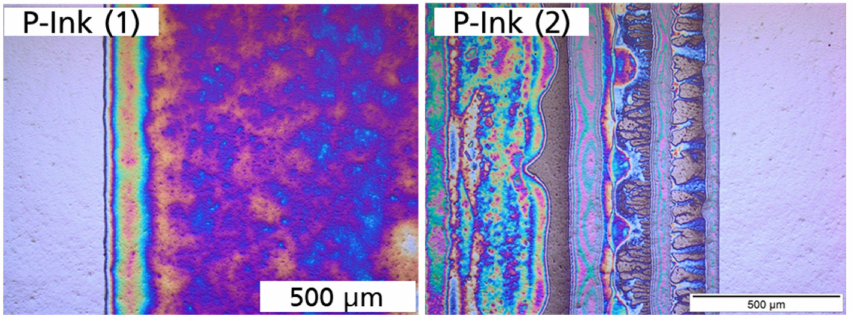
Figure 15. Optical microscope images captured at a resolution of 500 µ m, after high-temperature annealing in a tube furnace, for P-ink (1) and P-ink (2), printed on a shiny-etched surface of the FZ-Si wafer at a printing resolution of 600 × 600 dpi